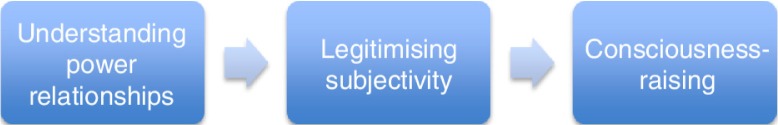
Intersectional focus group.